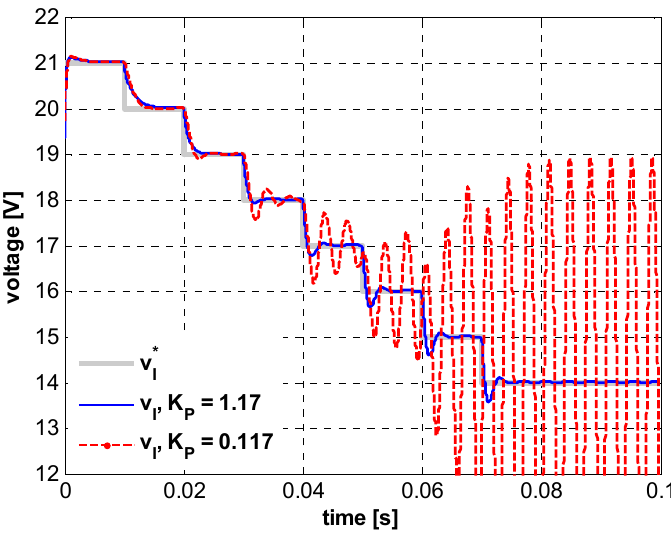
Figure 22. Closed-loop input voltage responses for different K P